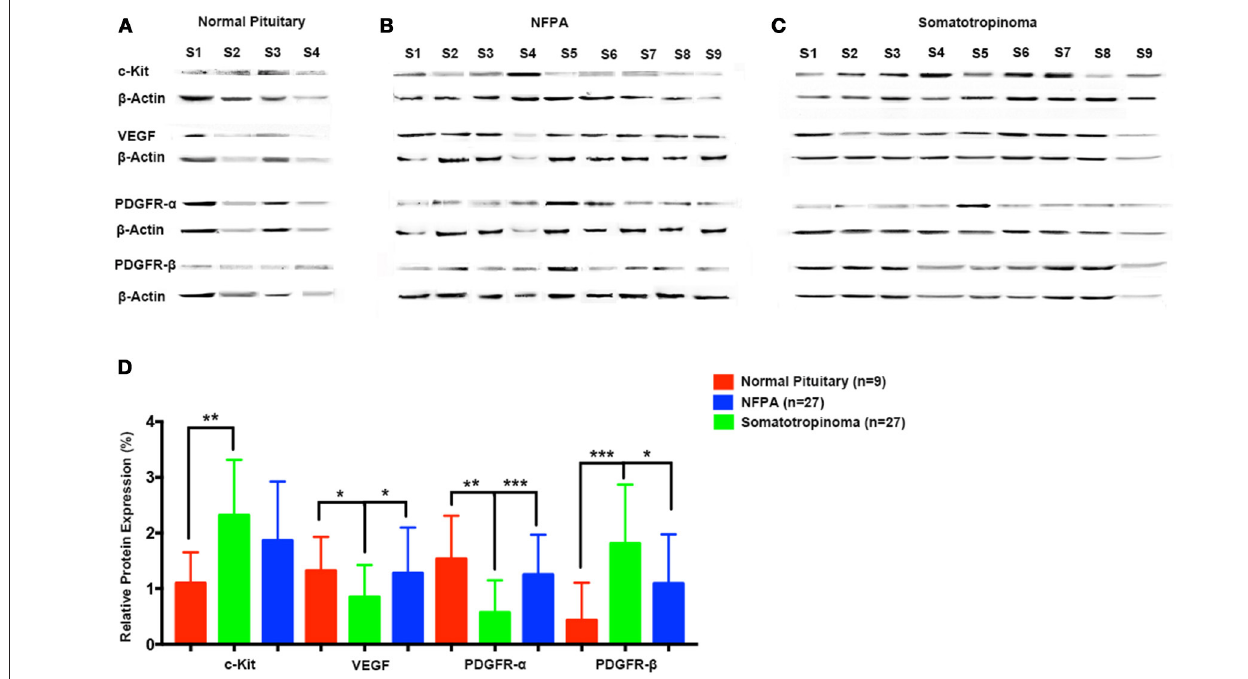
FIGURE 5 | Quantification of tyrosine kinases (c-Kit, VEGF, PDGFR- α , and PDGFR- β ) using western blot in (A) normal pituitary ( n = 9), (B) NFPA ( n = 27), and (C) somatotropinomas ( n = 27). Data were normalized to β -Actin and compared to expression in normal pituitary. (D) Similar to IHC findings, PDGFR- β and c-Kit was overexpressed in somatotropinoma ( P < 0.01) compared to normal pituitary whereas PDGFR- α was under expressed in somatotropinoma ( P < 0.05). * P < 0.05; ** P < 0.01 and *** P < 0.001.